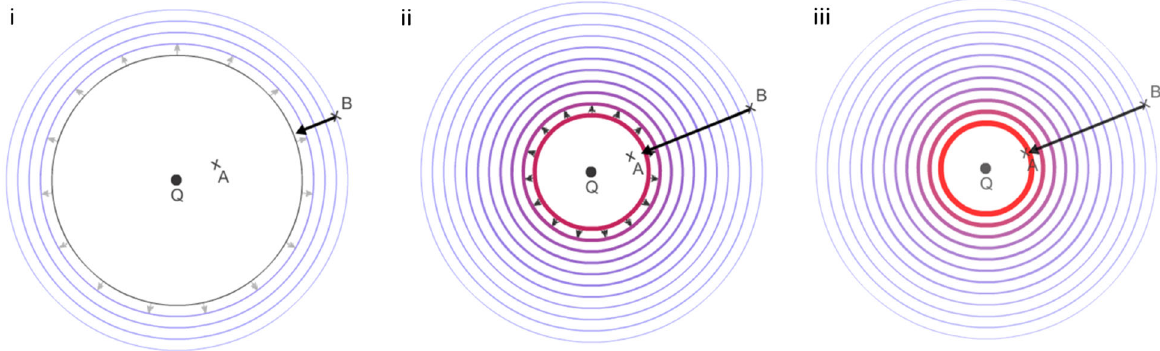
FIG. 7. Snapshots of the perceptually enhanced animation for the integral